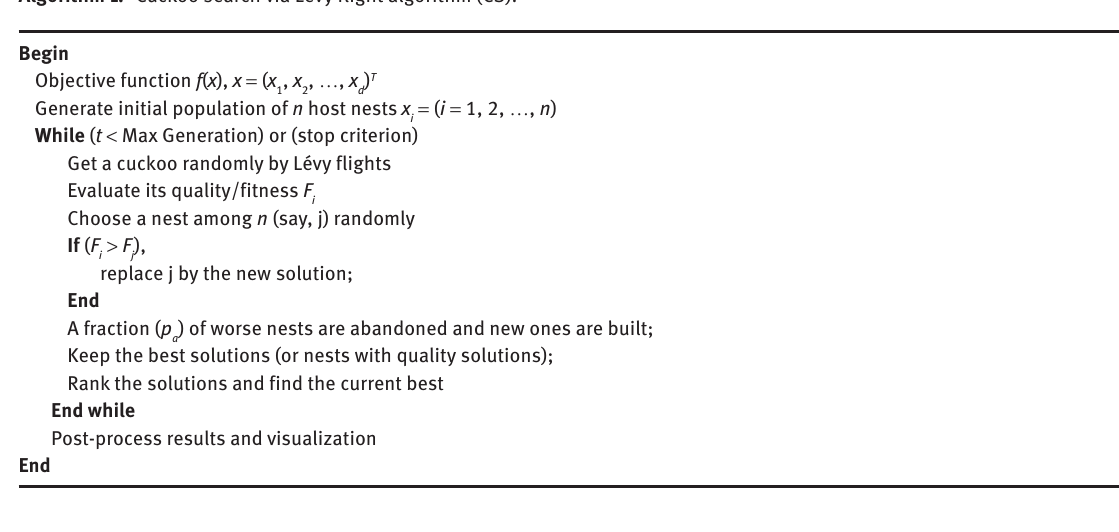
Algorithm 1. Cuckoo search via Lévy flight algorithm